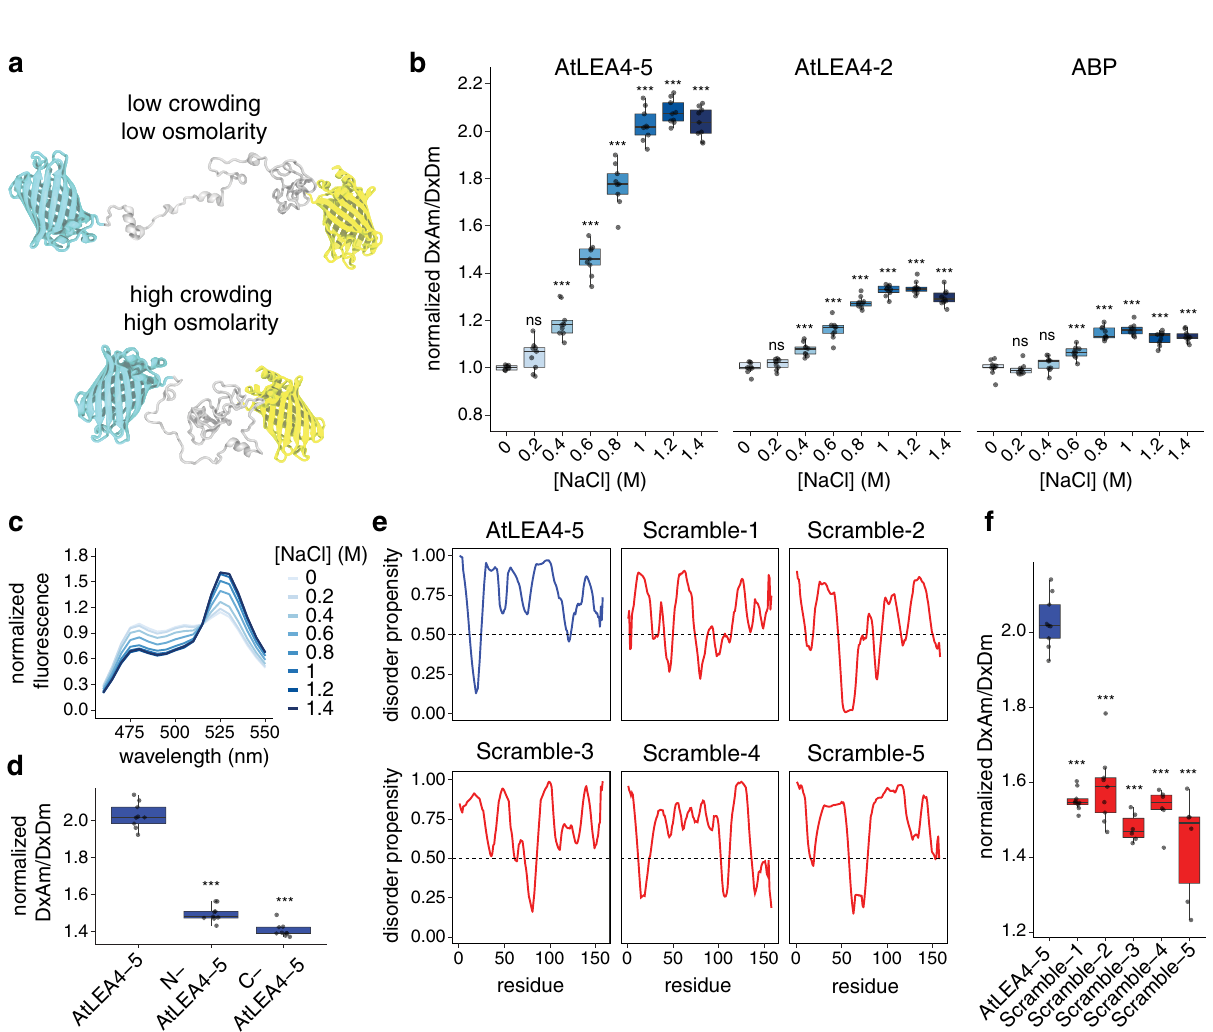
Fig. 1 Design of a biosensor for studying the effects of osmotic stress on living cells. a Schematic representation of the biosensor design under low and high macromolecular crowding/osmolarity — prevalent intracellular conditions upon hypoosmotic or hyperosmotic stress, respectively. The conformations are selected from the ensemble of all-atom simulations of AtLEA4-5 in the corresponding conditions. Cyan: mCerulean3. Yellow: Citrine. Gray: AtLEA4-5. b Normalized FRET ratio (DxAm/DxDm) of live yeast cells treated with different concentrations of NaCl. Cells are expressing the biosensor construct using either AtLEA4-5, AtLEA4-2, or arabinose-binding protein (ABP) as the sensory domain. n = 9 independent measurements. Two-way ANOVA. * p <0.05, ** p <0.01, *** p <0.001. Boxes represent 25th – 75th percentile (line at median) with whiskers at 1.5*IQR. c Fluorescence emission spectra of NaCl-treated live yeast cells expressing the biosensor construct using AtLEA4-5 as the sensory domain. Fluorescence values were normalized to the value at 515nm. d Normalized FRET ratio (DxAm/ DxDm) of live yeast cells expressing either AtLEA4-5, N-AtLEA4-5, or C-AtLEA4-5 biosensor constructs. Cells were treated with 1M NaCl. n = 9 independent measurements. One-way ANOVA. * p <0.05, ** p <0.01, *** p <0.001. Boxes represent 25th – 75th percentile (line at median) with whiskers at 1.5*IQR. e Disorder propensity prediction of AtLEA4-5 (blue) and fi ve different scrambled versions (red) using PONDR. Threshold at 0.5 disorder propensity is shown. f Normalized FRET ratio (DxAm/DxDm) of live yeast cells expressing AtLEA4-5 (blue) or fi ve different scrambled versions (red). n = 9 independent measurements. One-way ANOVA. * p <0.05, ** p <0.01, *** p <0.001. Boxes represent 25th – 75th percentile (line at median) with whiskers at 1.5*IQR. Source data are provided as a Source Data fi